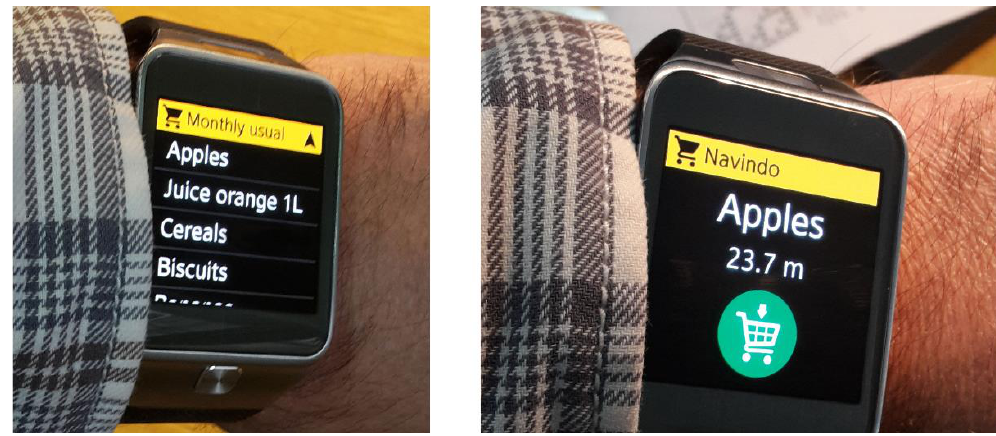
Figure 14. Smartwatch application.